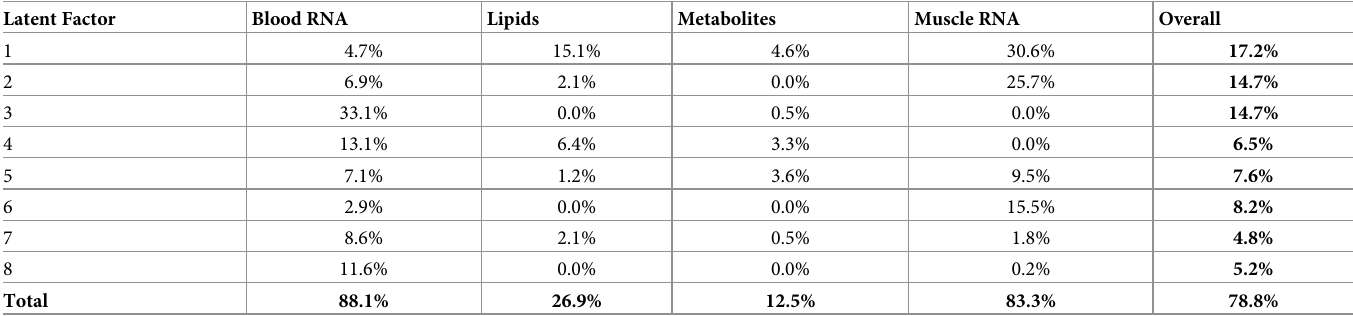
Table 1. Percentage of variance explained by each LF in each omic